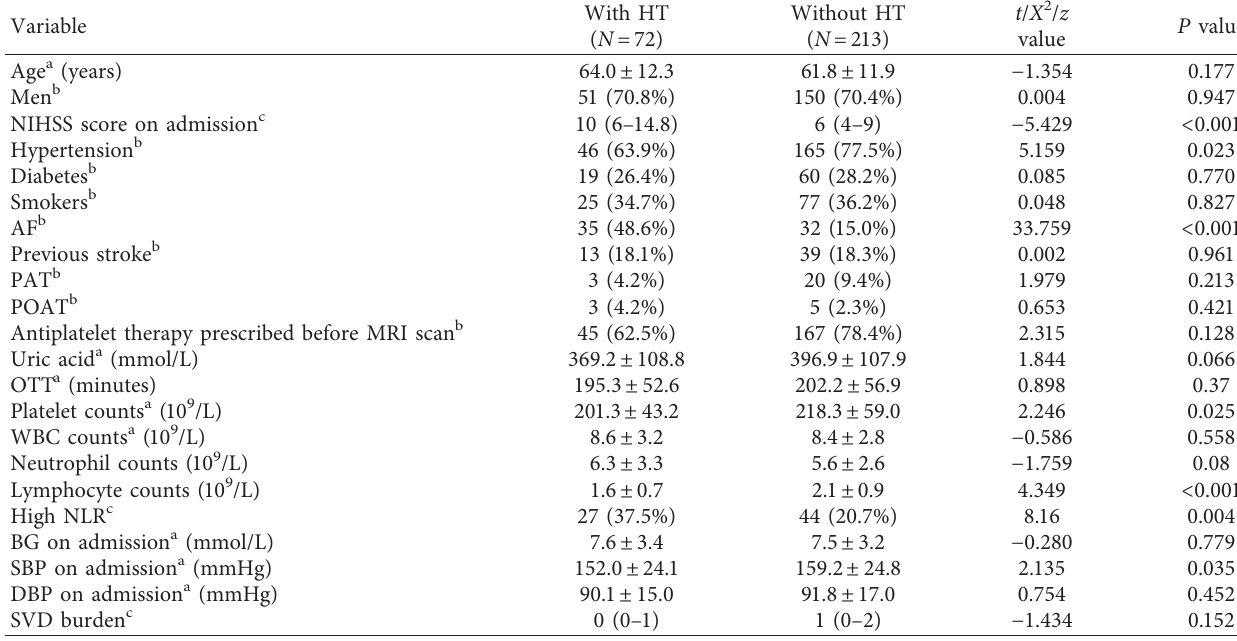
Table 2: Comparisons of clinicial and laboratory variables in IVT patients with and without HT.